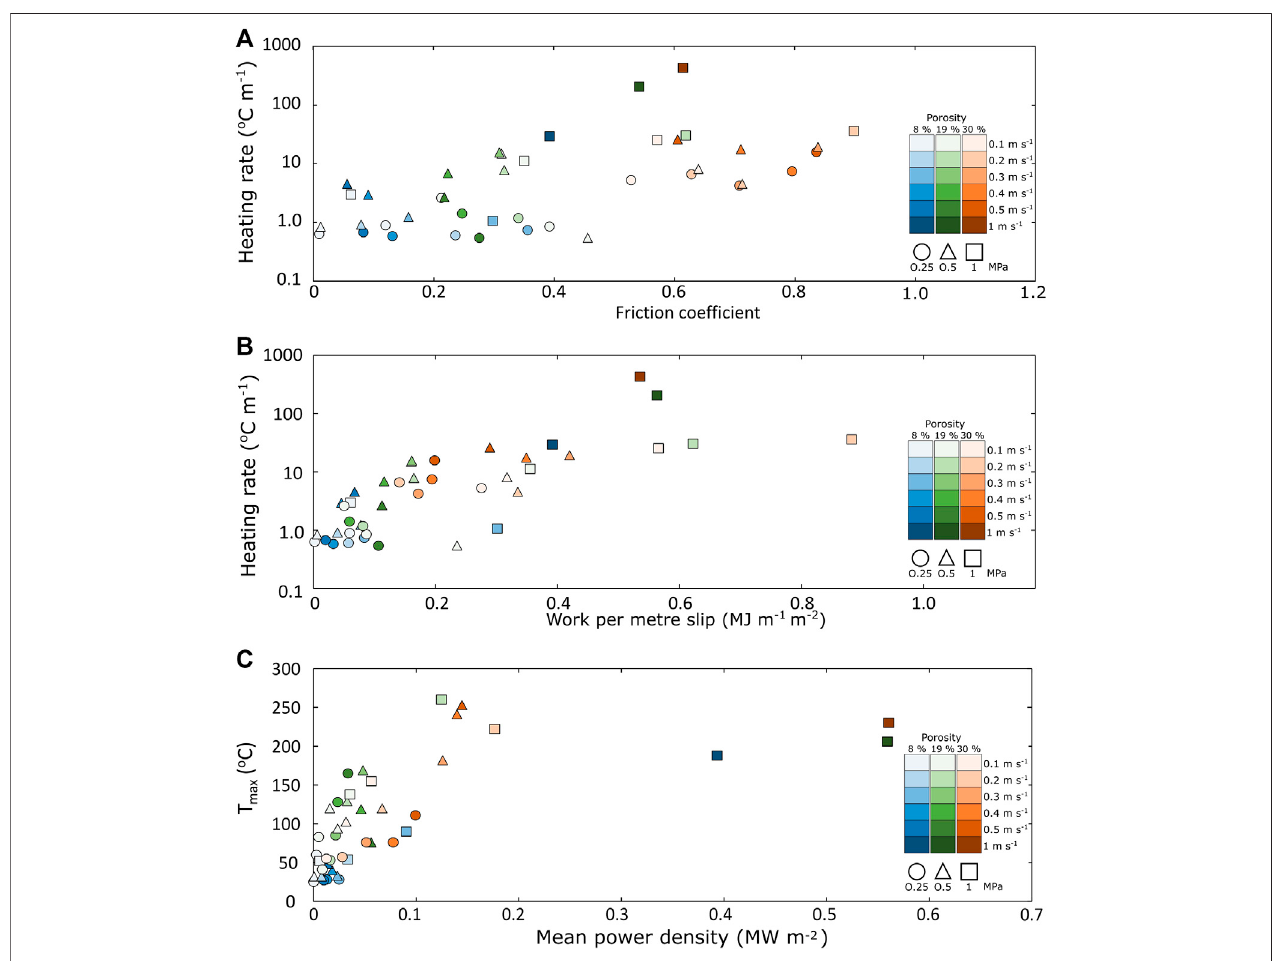
FIGURE 6 | Mechanical controls on frictional heat achieved during slip. (A) Heating rate plotted against friction coef fi cient for all tests, showing positive correlation. (B) Heating rate plotted against work per metre slip also showing positive correlation, with more work produced per metre of slip resulting in greater heating rates. (C) T max plottedagainstmeanpowerdensity.Notethat T max mayoccuratdifferentslipdistancesforeachtest.Acompletetemperaturerecordofallexperimentsisprovided in the Supplementary Material .